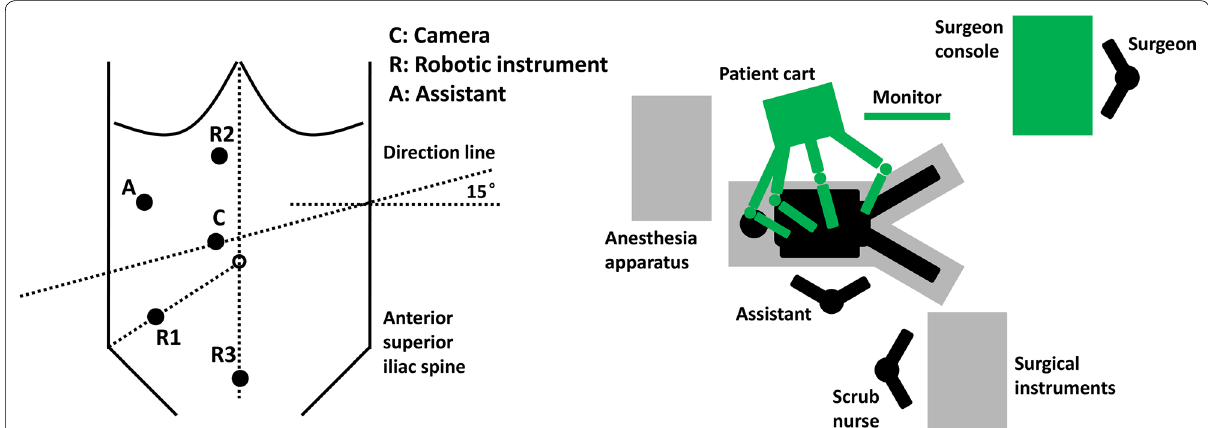
Fig. 3 Trocar location and operating room setup for robot-assisted radical resection of left-sided colon